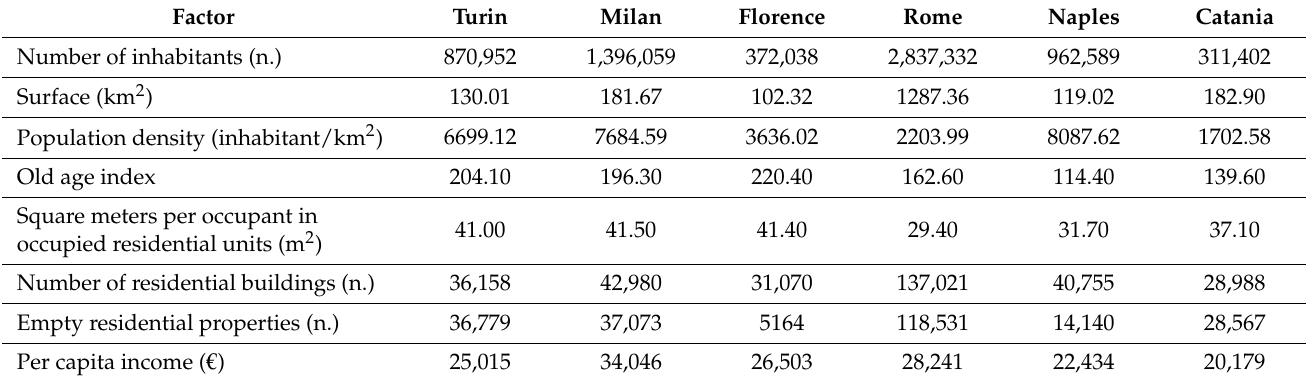
Table 1. Main distinctive features for each Italian city considered in the